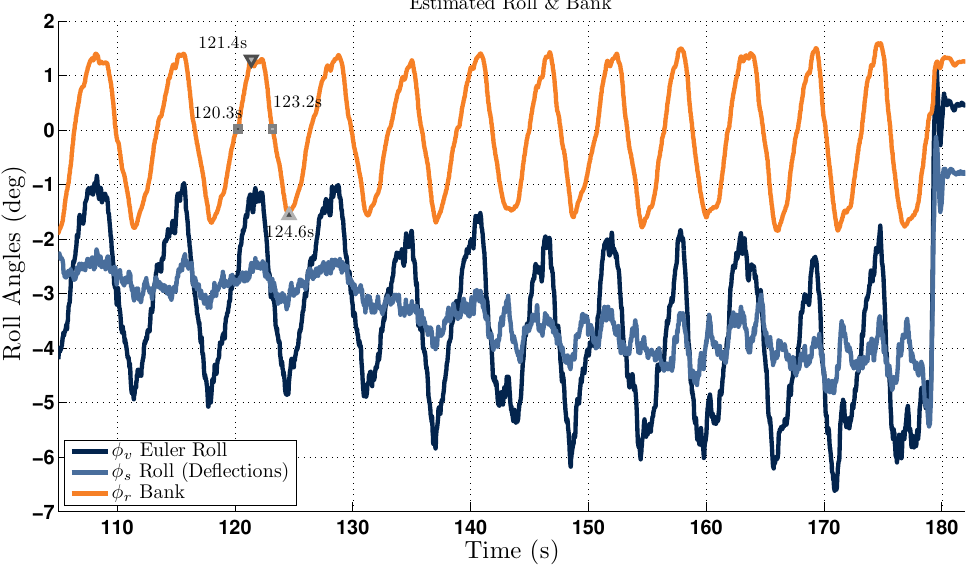
Figure 16. Coupled EKF on the NCAT skid pad 10-ft circle bank estimate.